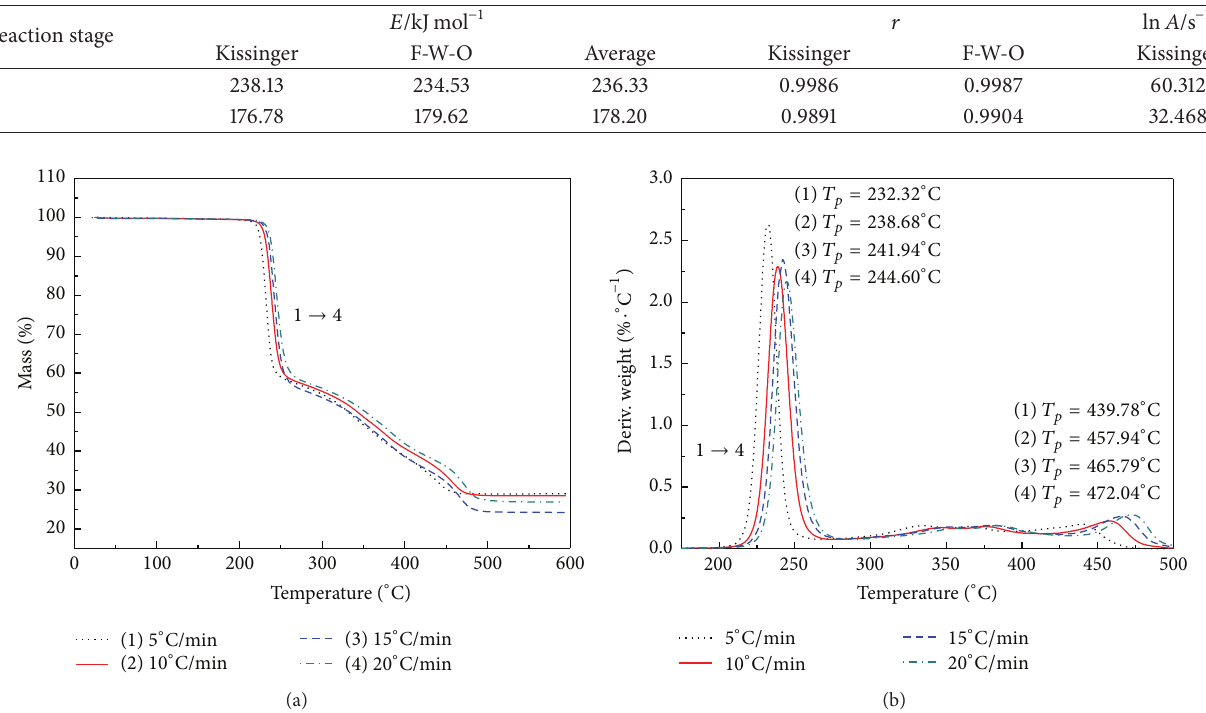
Figure 4: TG (a) and DTG (b) curves of the complex Mn ( HMHA ) 2 at different heating